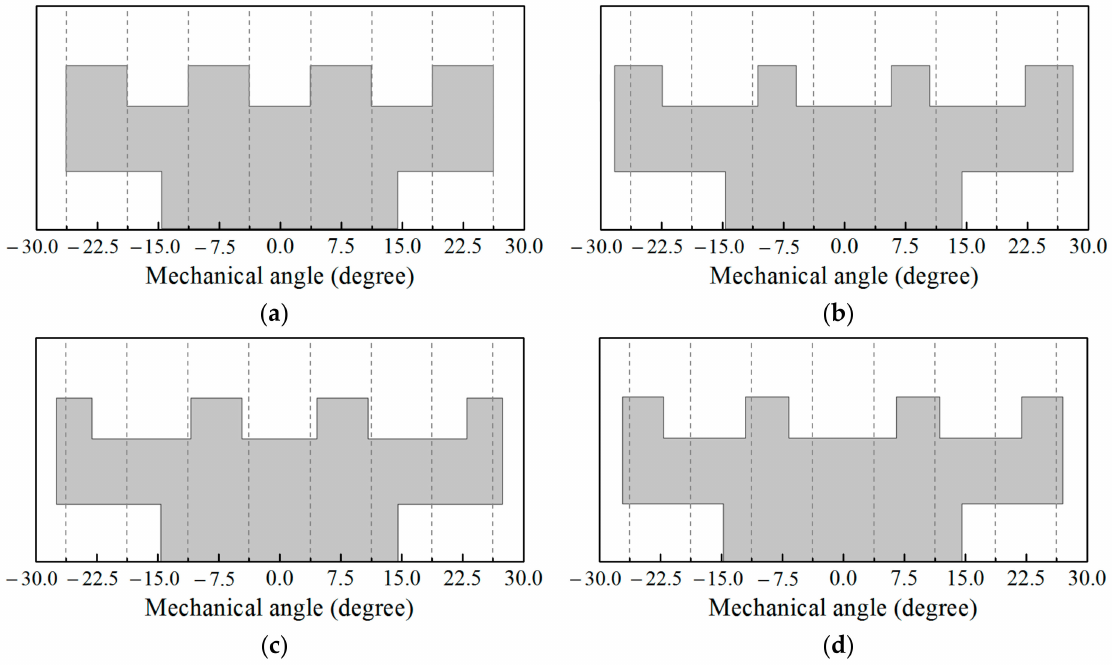
Figure 9. Geometries of the FMPs for the basic and optimal models. ( a ) Basic model; ( b ) OM1; ( c ) OM2; ( d )